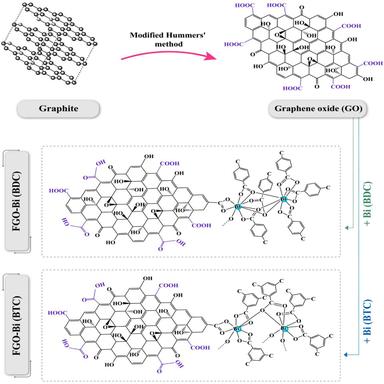
Schematic of synthesis of FGO-Bi(BDC) and FGO-Bi(BTC) composites.